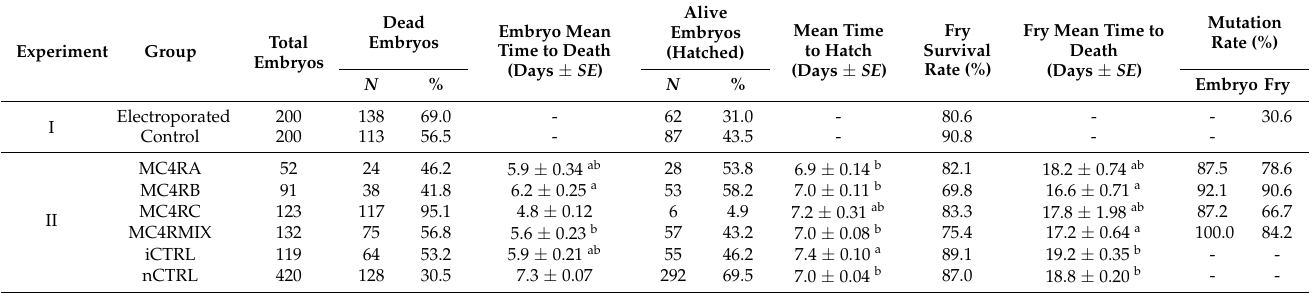
Table 3. The mortality, hatchability, and survival of electroporated (experiment I) and microinjected fry (experiment II) from the Kansas random strain of channel catfish, Ictalurus punctatus . In experiment I, one-celled embryos were electroporated with sgRNA and Cas9 plasmids targeting the channel catfish melanocortin-4 receptor ( mc4r ) gene, while the control group was electroporated with TE buffer without plasmids. In experiment II, one-celled embryos were microinjected with sgRNAs-Cas9 protein targeting the same gene. Three groups were injected with individual sgRNAs (MC4RA, MC4RB, and MC4RC), while MC4RMIX was injected with a mixture of the three sgRNAs and Cas9. Two control groups were used for experiment II, including an injected control (injected with the same injection solution but without sgRNA or Cas9, iCTRL) and a non-injected control (nCTRL).